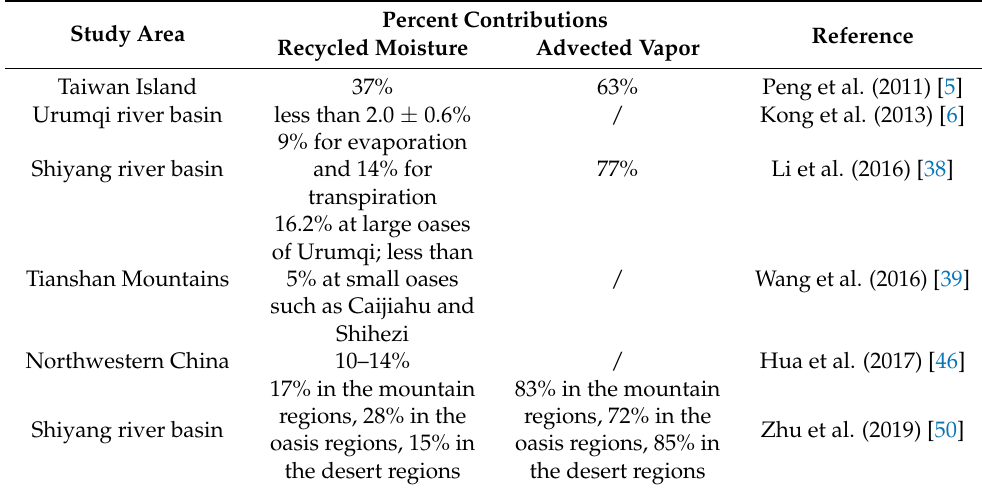
Table 1. Percent contributions of recycled moisture to local precipitation in China in previous